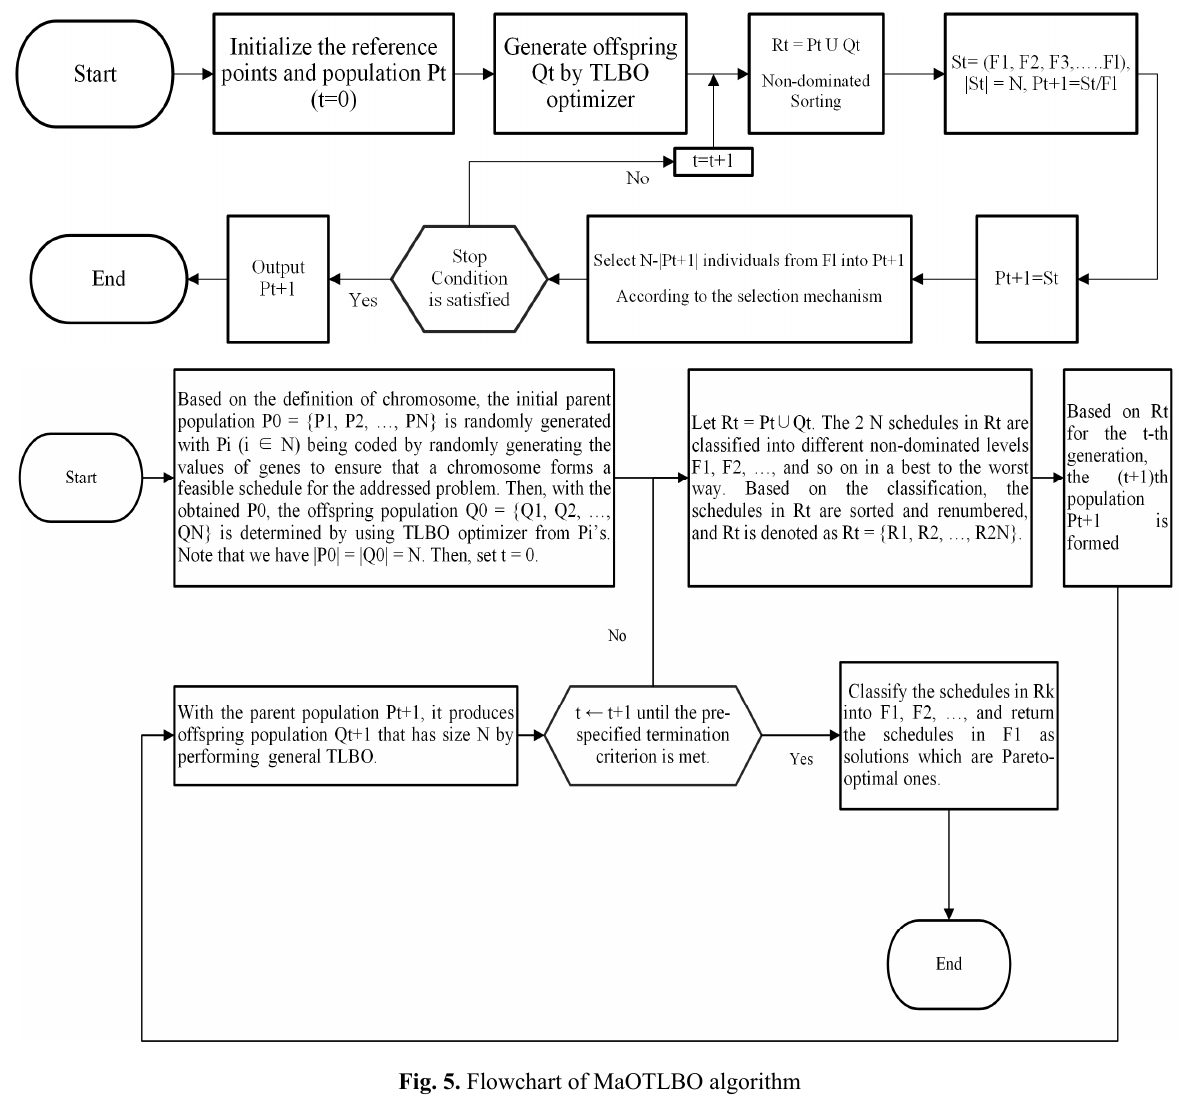
Fig. 5. Flowchart of MaOTLBO